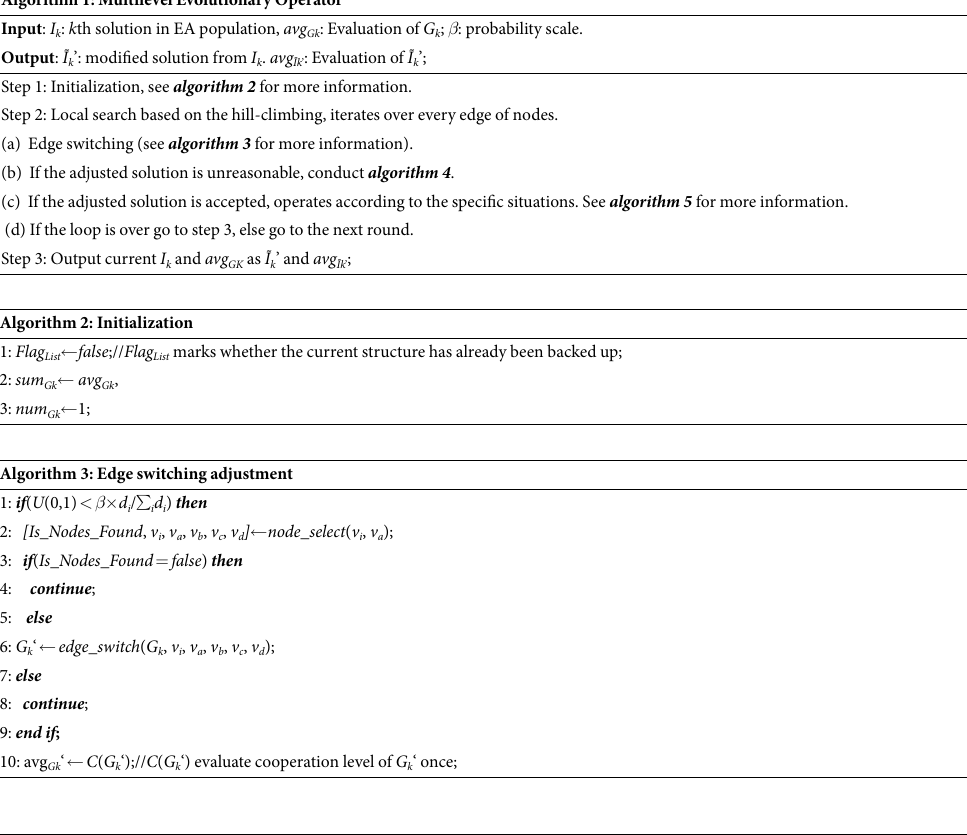
Algorithm 4: Operation when edge switching adjustment is rejected